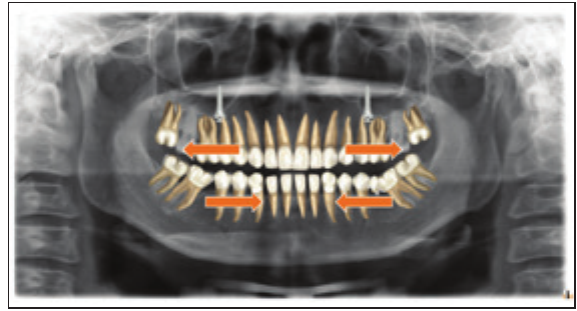
Figure 3. Objectives of orthodontic treatment.